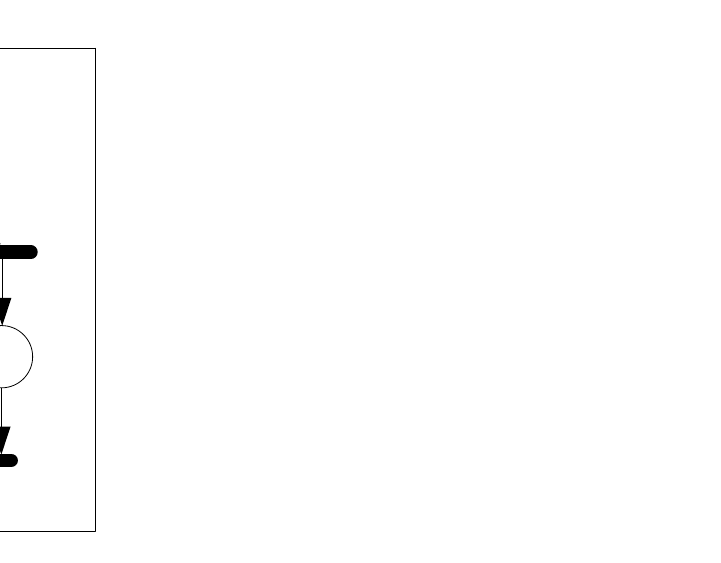
Figure 7. A corrected Petri net—bounded, but not live.